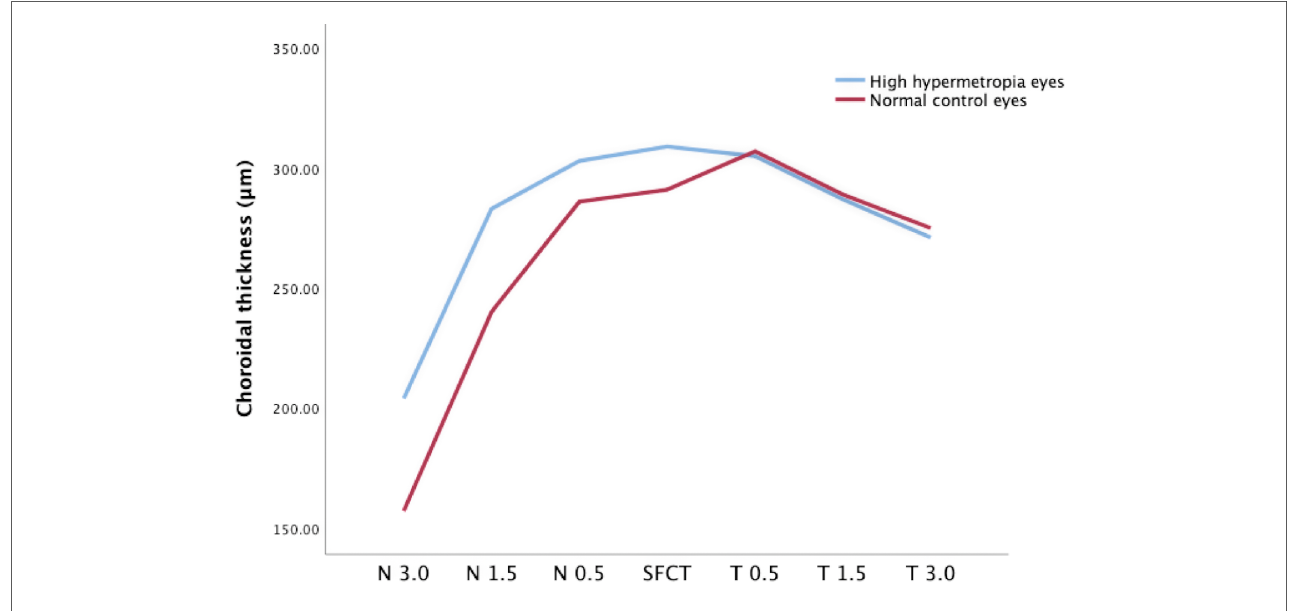
FIGURE 3 CT at different locations of high hyperopia and normal